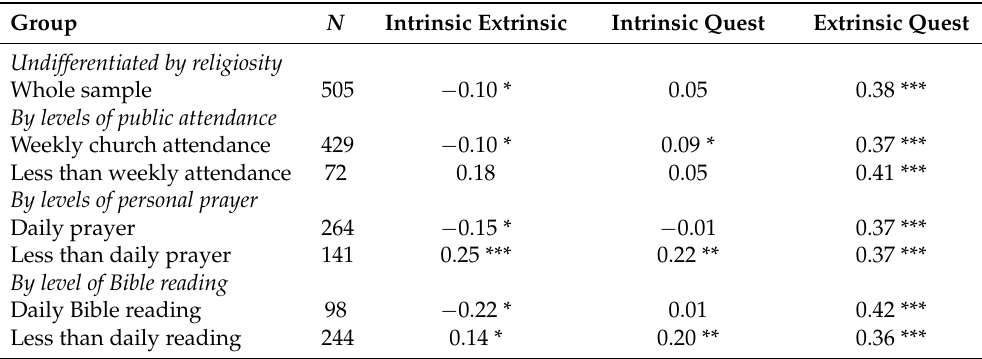
Table 5. Intercorrelations among different